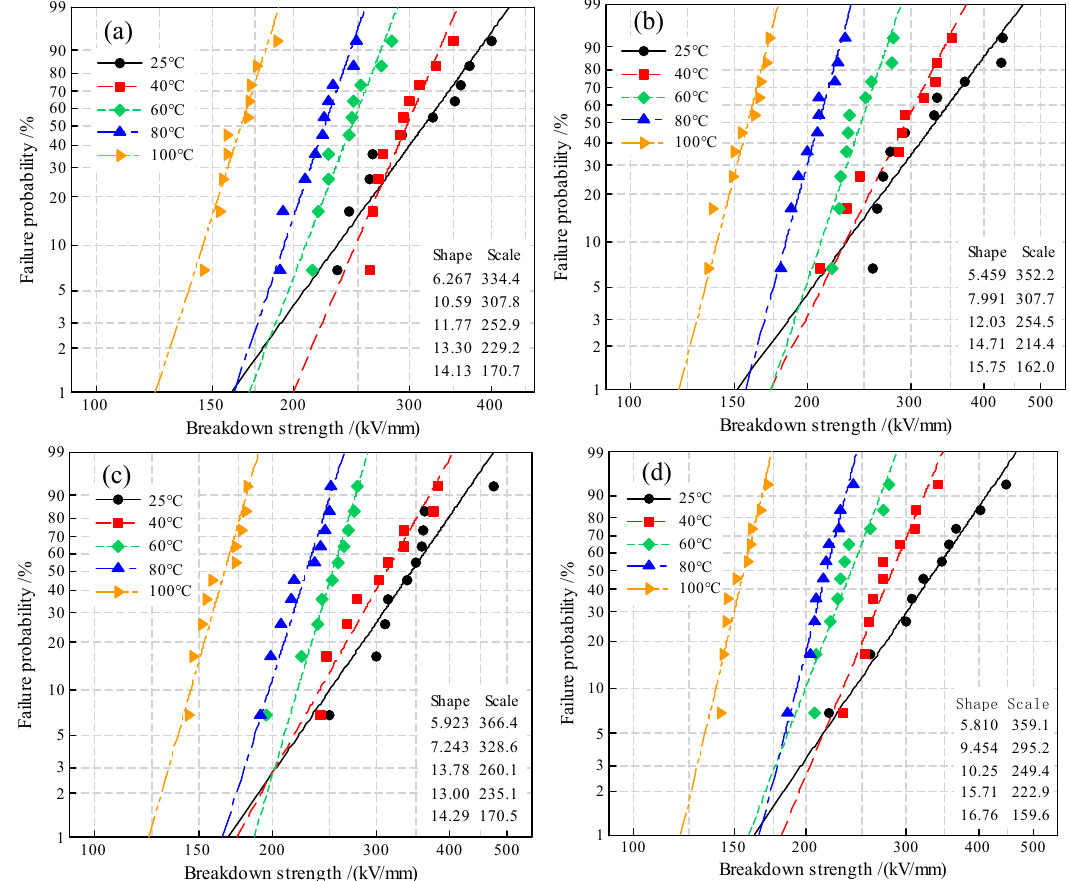
Figure 7. DBS statistics fitted with 2-parameter Weibull distribution at temperatures of 25~100 °C for ( a ) pure XLPE and the nanocomposites of ( b ) 0.5wt%TAIC- s -SiO 2 /XLPE, ( c ) 1.5wt%TAIC- s - SiO 2 /XLPE and ( d ) 2.0wt%TAIC- s -SiO 2 /XLPE. Table 2. Characteristic breakdown field E b at 63.2% probability and shape parameter β obtained by fitting the DBS experimental data with 2-parameter Weibull distribution at 95% confidence interval.